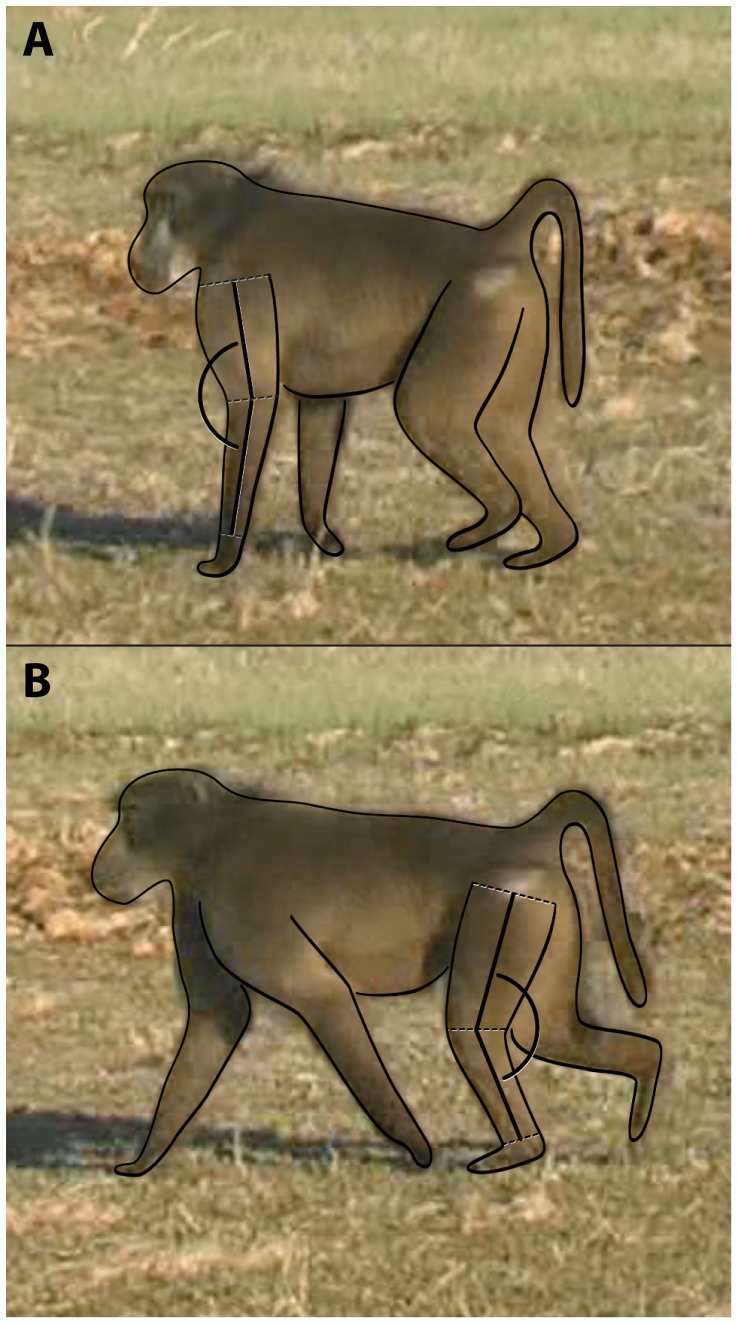
Angle measurements.Illustration showing how joint angles (in degrees) were measured. (A) Elbow joint angle was measured as the angle between the arm segment and the forearm segment. A line determined the arm segment with its proximal end approximating the midpoint between the anterior and posterior contours of the arm at the shoulder joint and the distal end approximating the midpoint between the anterior and posterior contours of the elbow joint. A line determined the forearm segment with its proximal end approximating the midpoint between anterior and posterior contours of the elbow joint and the distal end approximating the midpoint between the anterior and posterior contours of the wrist joint. (B) Knee joint angle was measured as the angle between the thigh segment and the leg segment. A line determined the thigh segment with its proximal end approximating the midpoint between the anterior and posterior contours of the thigh at the hip joint and the distal end approximating the midpoint between the anterior and posterior contours of the knee joint. A line determined the leg segment with its proximal end approximating the midpoint between anterior and posterior contours of the knee joint and the distal end approximating the midpoint between the anterior and posterior contours of the ankle joint.